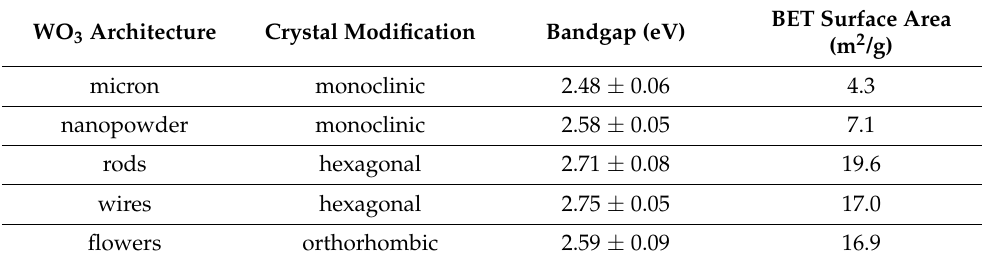
Figure 2. ( a ) Diffuse reflectance spectra of WO 3 particles ( b ) Kubelka–Munk-treated plots of WO 3 particles. Table 1. Characteristics of different WO 3 materials and methanol productivity.